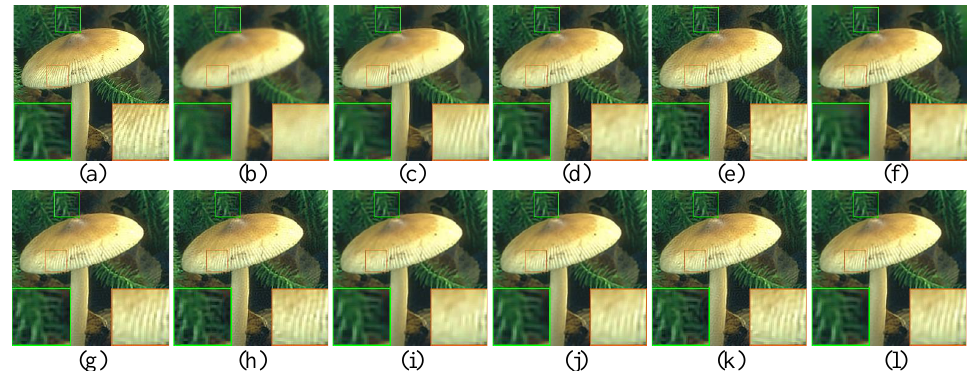
Figure 6. Visual comparison of Agaric by image deblurring with Gaussian kernel. ( a ) Original image; ( b ) noisy and blurred image (fspecial(‘gaussian’, 25, 1.6), σ n =